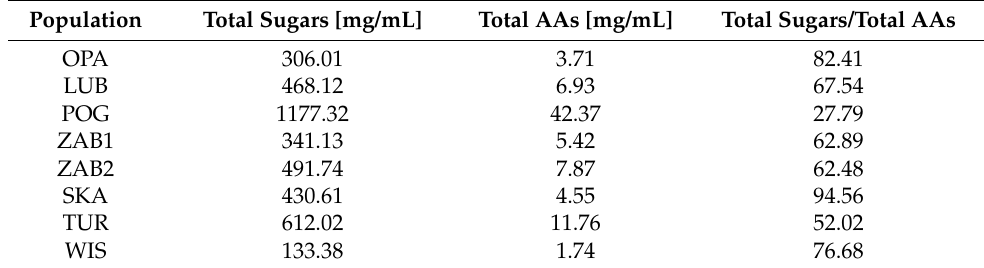
Table 6. Sugar and amino acid ratio in Neottia ovata populations.